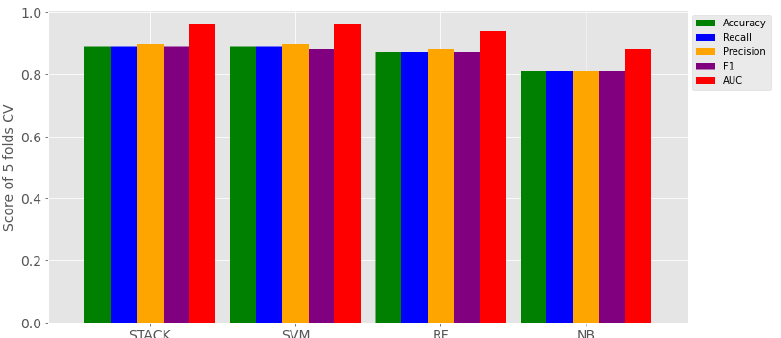
Figure 6. Comparison of the Performance of Proposed Stacking Sentiment Classifier with base Ma‑ chine Learning Classifier using all four data sets with character(1,7) + SMOTE based on five metrics (accuracy, precision, recall, F1 score, and Area Under the Curve (AUC)).